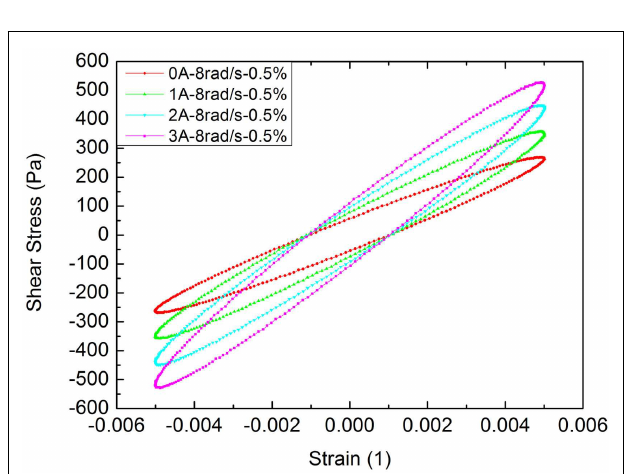
FIGURE 8 | Storage modulus as function of current for MRE and MRSSE